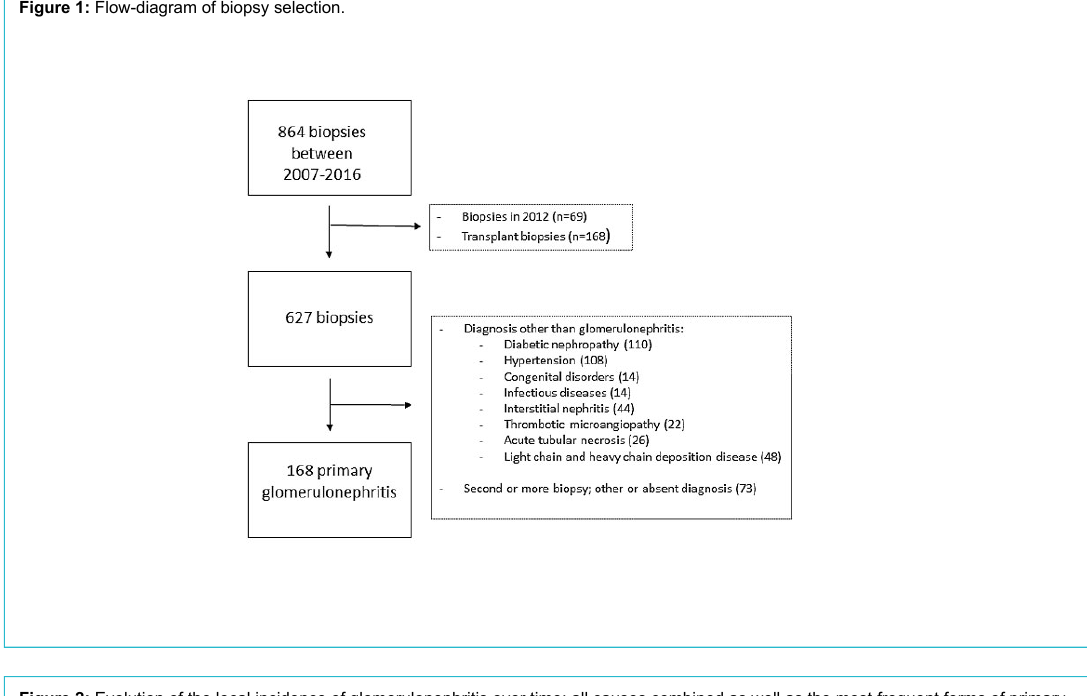
Figure 1: Flow-diagram of biopsy selection.